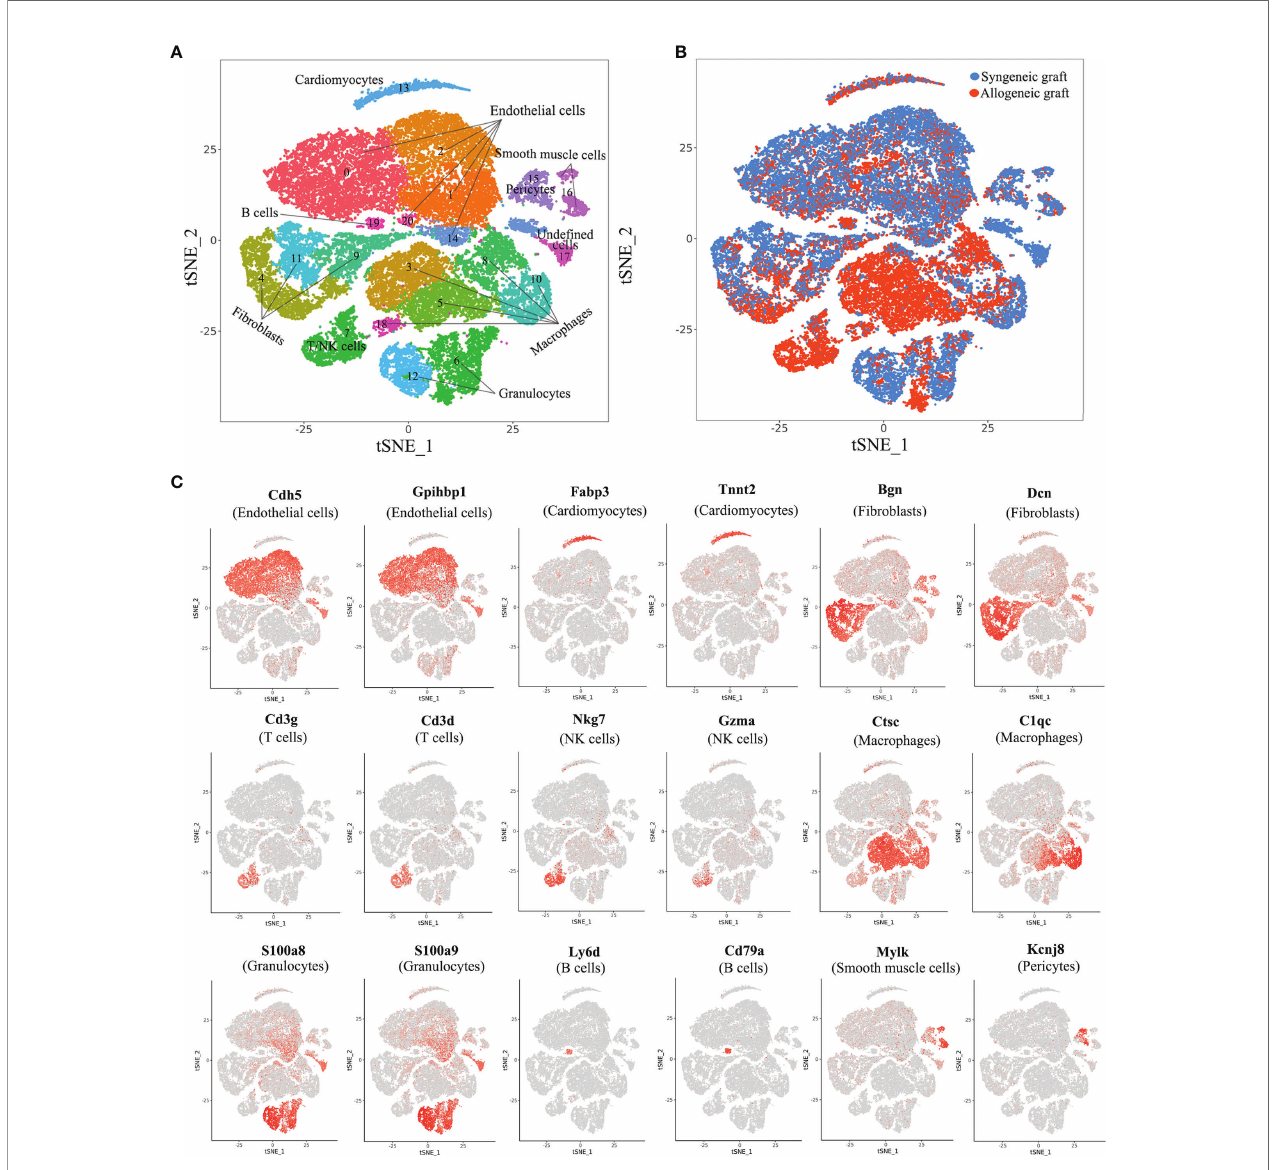
FIGURE 1 | Comprehensive scRNA-seq analysis of cell types in syngeneic and allogeneic heart grafts. (A) Single-cell transcriptomes of cardiac cells in two syngeneic and two allogeneic heart grafts collected on Day 5 post-transplant were analyzed with an unsupervised dimensionality reduction algorithm (Seurat) to identify groups of cells with similar gene expression pattern. Each dot stands for a cell. (B) Distribution of cells originating from syngeneic graft or allogeneic graft as indicated in (A) . (C) Canonical cell markers were used to characterize cell clusters in the t-SNE plot, including endothelial cells, cardiomyocytes, fi broblasts, T cells, macrophages, granulocytes, B cells, smooth muscle cells and